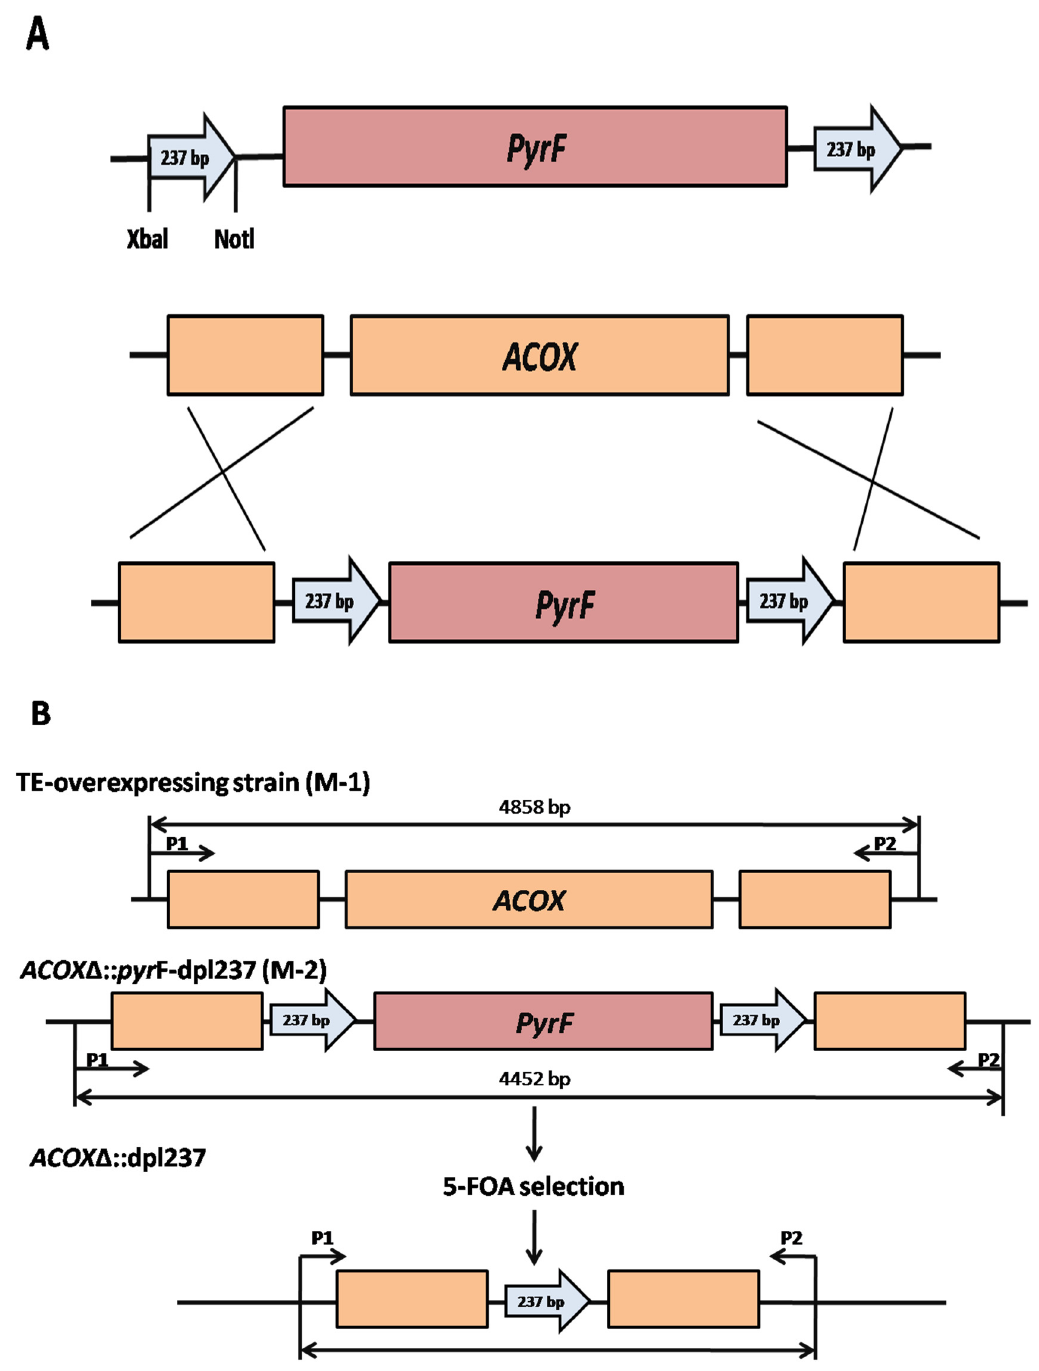
Figure 4. Disruption of the ACOX gene and confirmation of the excision of the pyrF marker. ( A ) Homologous replacement of the ACOX gene with the pyrF recyclable marker. ( B ) Confirmation of the excision of the pyrF marker. Strain MYS720 ( acox Δ :: pyrF-dpl237 ) was inoculated on yeast peptone glucose agar (YPG) medium containing 5-FOA. After 3 d of incubation, spontaneous resistant mutants emerged to form a sector from the colony (data not shown). The 5-FOA resistant mutants underwent a vegetative cycle on YPG medium containing 5-FOA. The obtained spores were subjected to polymerase chain reaction (PCR) analysis and auxotrophy tests. Excision of the pyrF marker from the acox Δ :: pyrF-dpl237 allele was confirmed by PCR (see details in Section 2.5). The strains with the excised pyrF marker did not grow on media without leucine. Two independent ( acox Δ ::dpl237 ) strains were obtained.